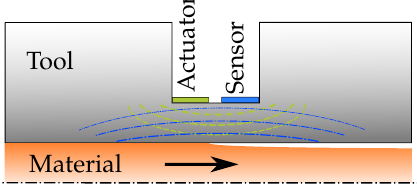
Figure 1. Actuator and sensor design inside a pultrusion tool before optimization.